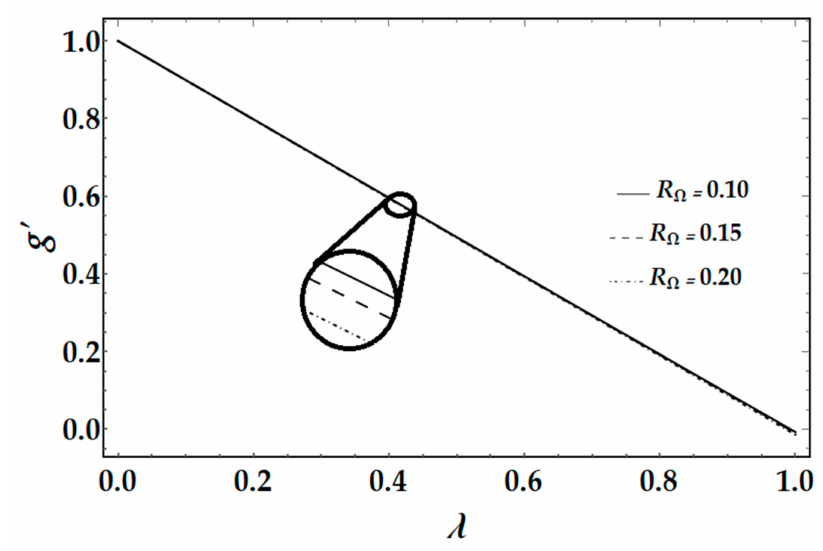
Figure 5. Implications of R Ω on velocity distribution (tangential) g (cid:48) ( λ )